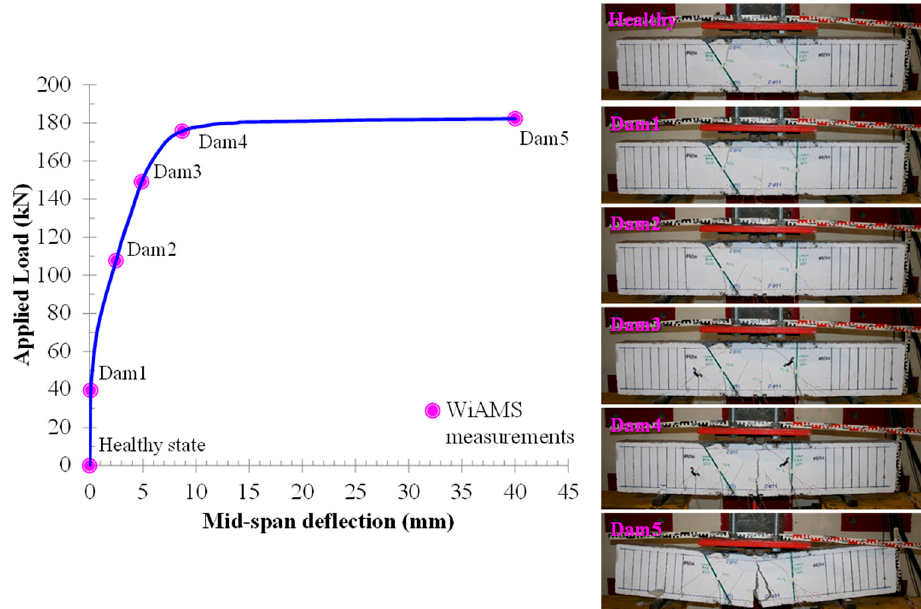
Figure 6. Cracking pattern and experimental behavior of specimen R-FRP.